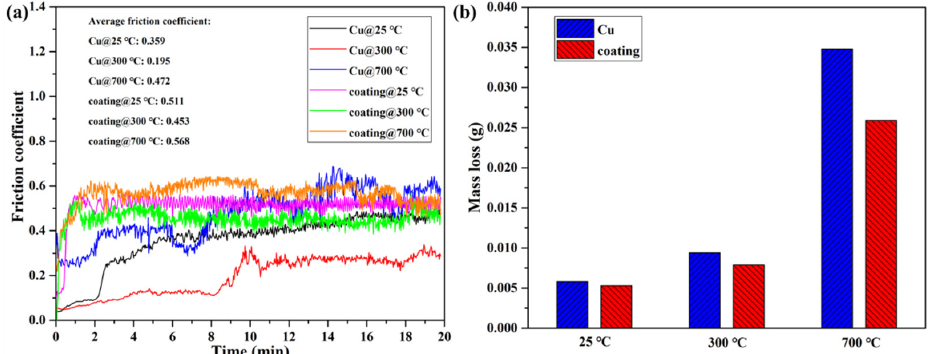
Figure 11. Friction and worn behavior of the Cu35Ni25Co25Cr15 HEA coating deposited under a welding current of 150 A and the pure Cu at different temperatures: ( a ) friction coefficient; ( b ) wear mass loss.